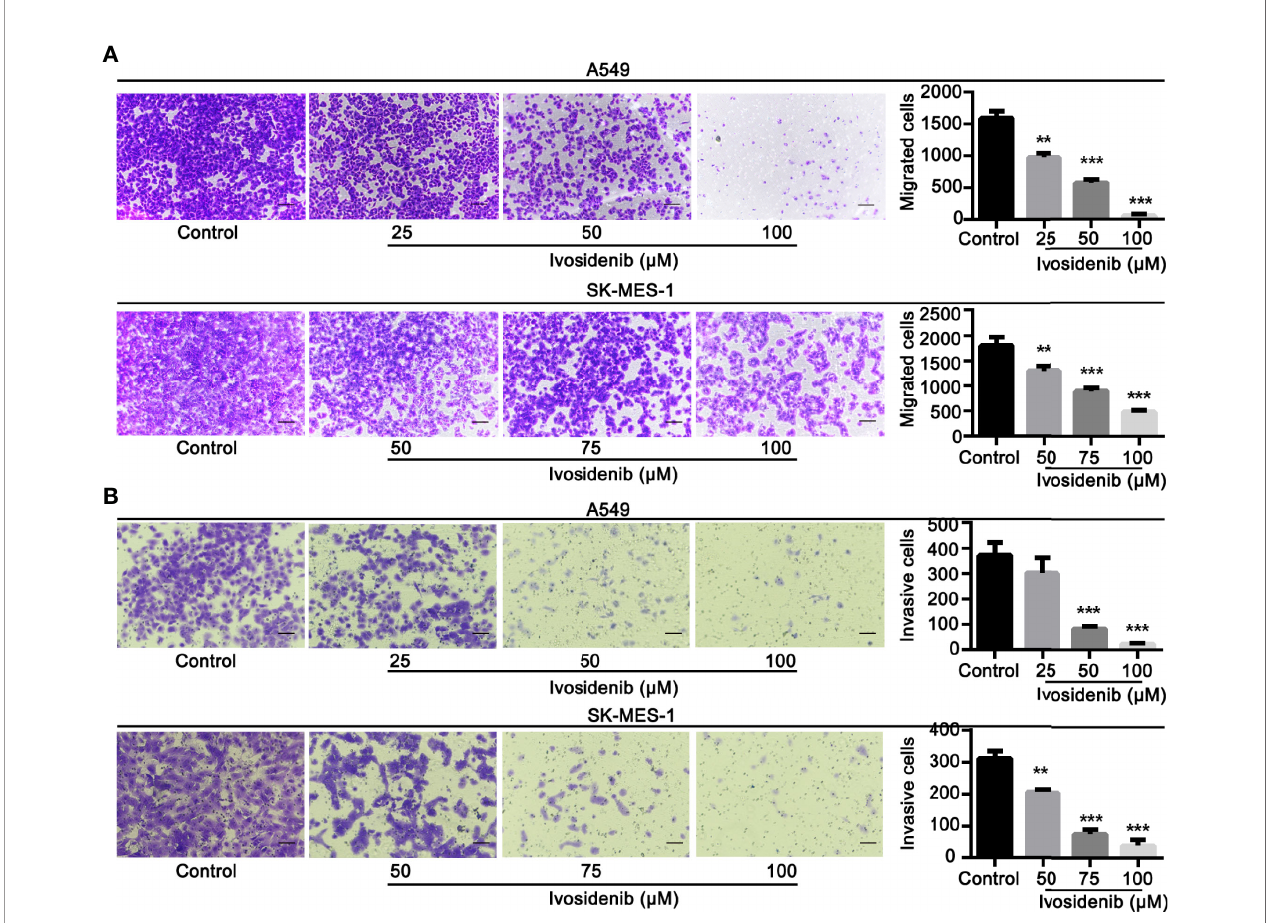
FIGURE 3 | Ivosidenib inhibits invasion and migration of NSCLC cells. (A) A549 were treated with 25, 50, and 100 µM of ivosidenib for 24 h to measure migration. SK-MES-1 were treated with 50, 75, and 100 µM of ivosidenib for 24 h to measure migration. (B) A549 were treated with 25, 50, and 100 µM of ivosidenib for 48 h to measure migration. SK-MES-1 were treated with 50, 75, and 100 µM of ivosidenib for 48 h to measure migration. The quantitative results are shown in the right panel, and data are expressed as mean ± SD of three independent experiments. ** p < 0.01, and *** p < 0.001 vs.